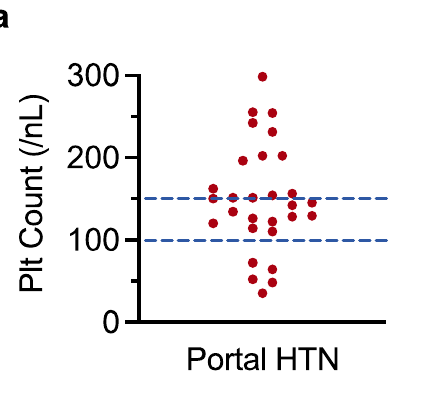
Figure 4. Low platelet count increases the risk of perioperative mortality in resectable HCC. ( a , b ) Results of a t -test analysis showing the association of platelet count with perioperative mortality (3-month postoperative mortality) in ( a ) and with 12-month postoperative mortality in ( b ). The result in ( a ) with a p -value < 0.1 was considered a statistical trend.